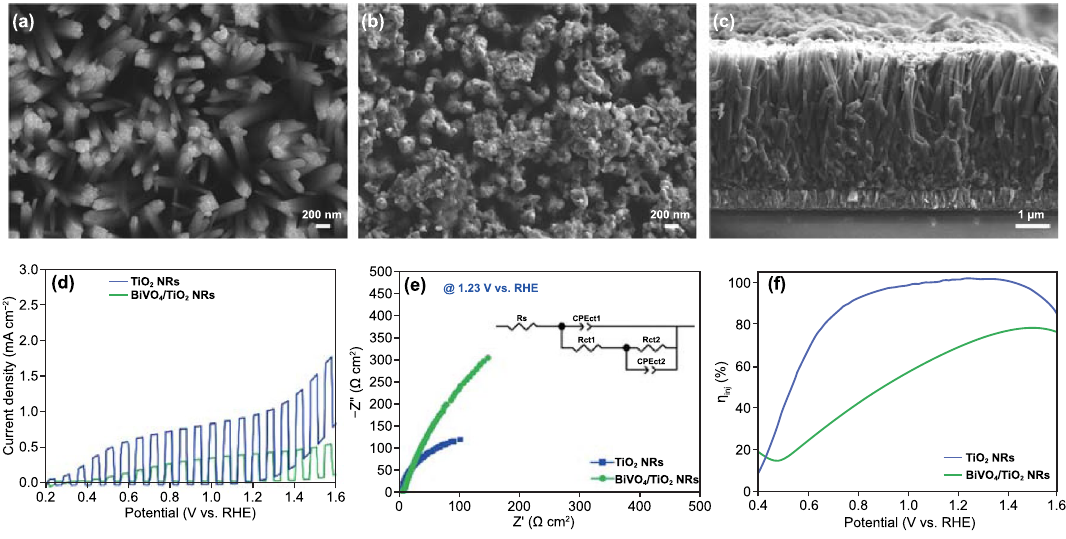
Fig. 2 Top SEM images of a TiO 2 NRs and b BiVO 4 /TiO 2 NRs. c Cross‑sectional SEM image of BiVO 4 /TiO 2 NRs. d LSV for TiO 2 NRs and BiVO 4 /TiO 2 NRs in 0.5M K–Pi buffer with 1M Na 2 SO 3 . e Electrochemical impedance spectra (EIS) of TiO 2 NRs and BiVO 4 /TiO 2 NRs at 1.23 V (vs. RHE) in 0.5M K– Pi buffer with 1M Na 2 SO 3 . Inset shows equivalent circuit. f Charge injection efficiency of TiO 2 NRs and BiVO 4 / TiO 2